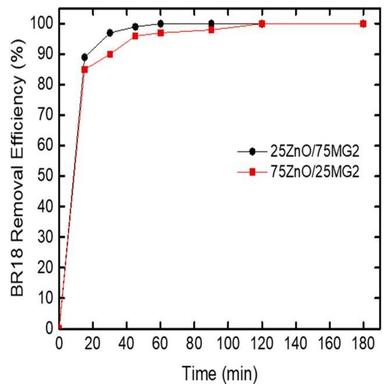
Photocatalytic degradation of BR18 dye for 25ZnO/75MG2 and 75ZnO/25MG2.